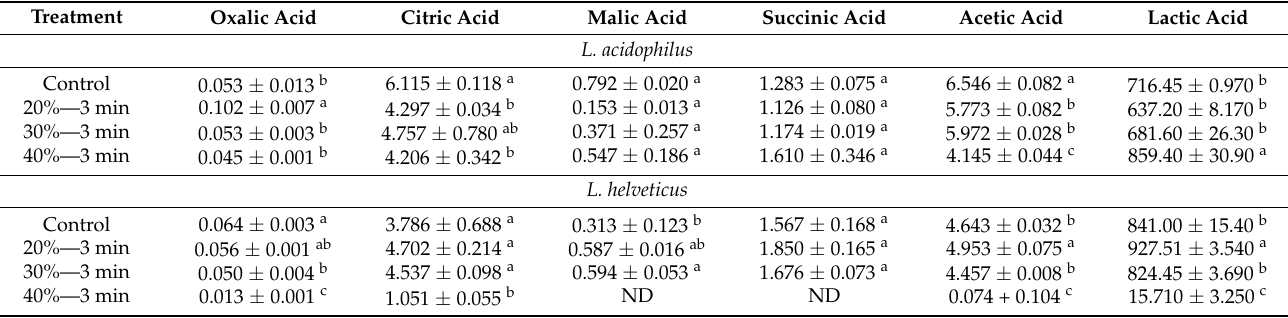
Table 3. Effects of ultrasounds (20 kHz) on the production of organic acids (mM) of L. acidophilus and L. helveticus